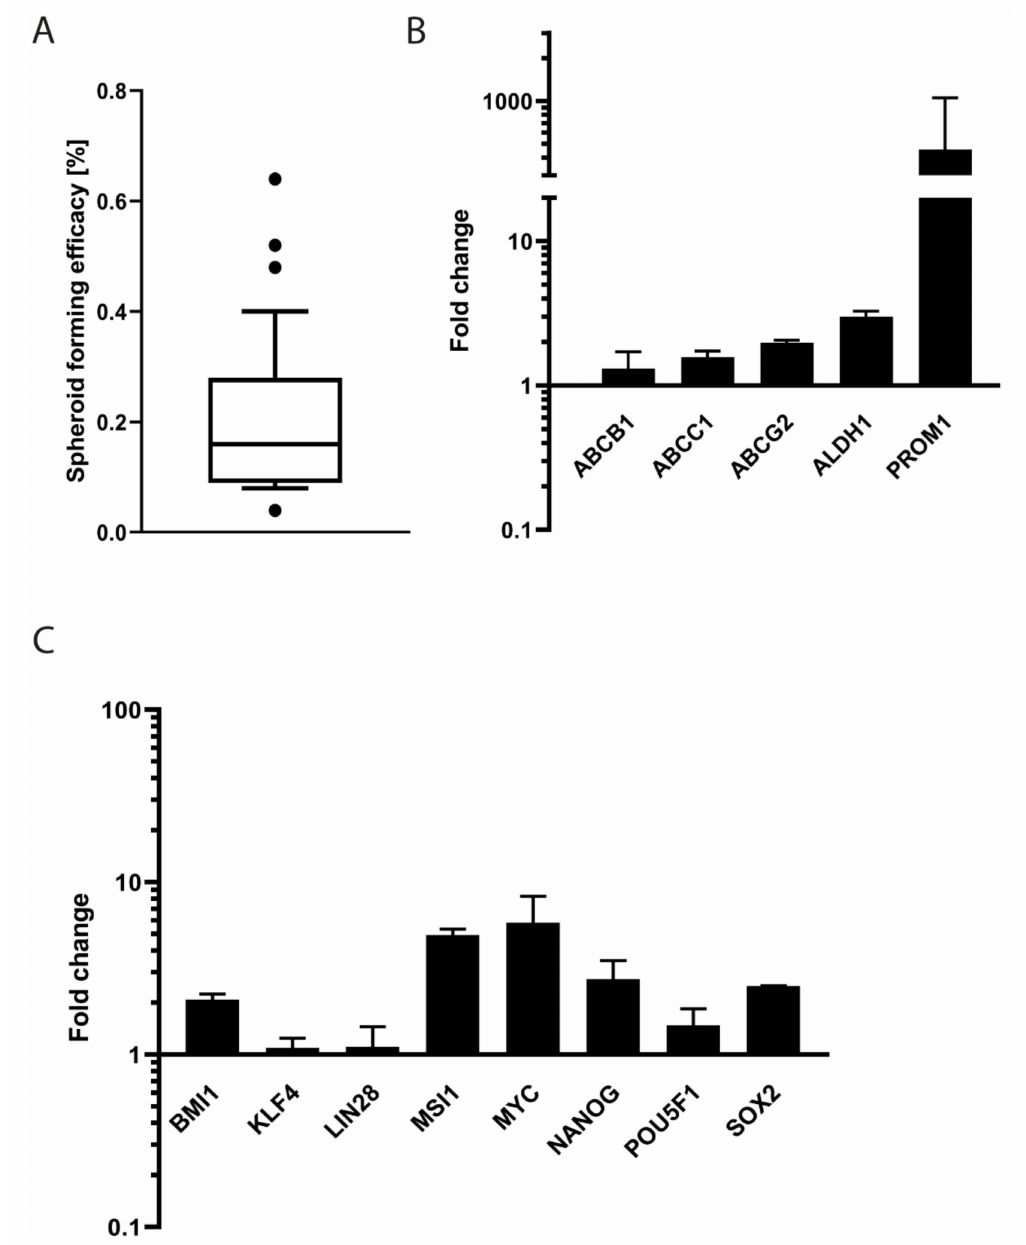
Figure 8. Expression of CSC and ESC markers in SRH spheres. ( A ) Sphere forming e ffi cacy (%) was calculated as number of tumor spheres divided by number of cells seeded × 100. Outliers are indicated as dots. ( B , C ). Total RNA was extracted from SRH tumor spheres and monolayer cultures. Quantitative RT-PCR was performed for the genes ABCB1 , ABCC1 , ABCG2 , ALDH1 , PROM1 , BMI1 , KLF4 , LIN28 , MSI1 , MYC , NANOG , POU5F1 , and SOX2 in triplicate and normalized to the housekeeping gene YWHAZ . The expression levels relative to monolayer culture are shown. Error bars indicate the standard